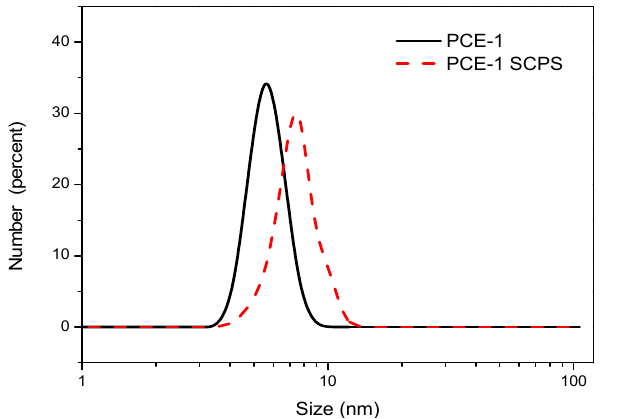
Figure 11. Hydrodynamic diameter of PCE-1 in water and in the simulated stone powder solution (SCPS).